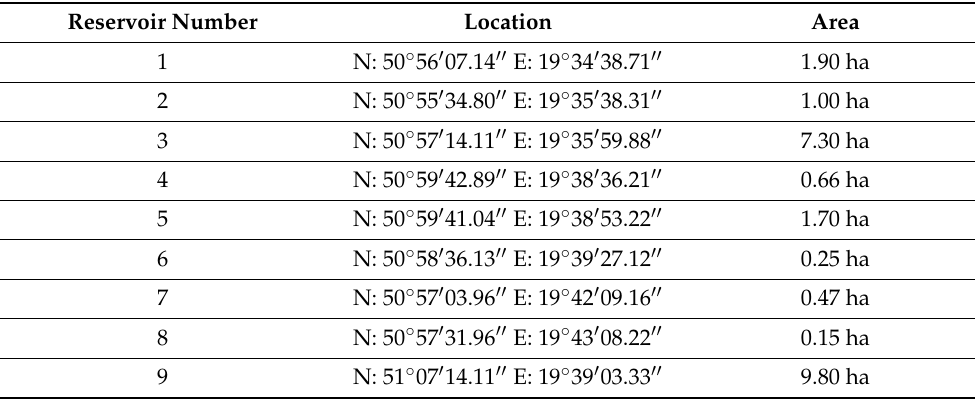
Table 1. Location and surface area of the studied